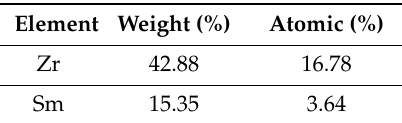
Table 1. Quantitative EDS analysis results obtained from point 1 on the surface of the sample presented in Figure 6 (only for Zr and Sm).